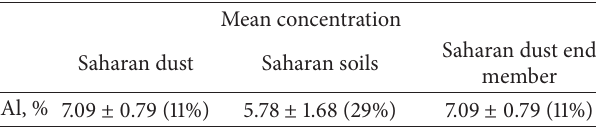
Table 2: Mean concentration of Al included in mineral Sahara dust according to [54].